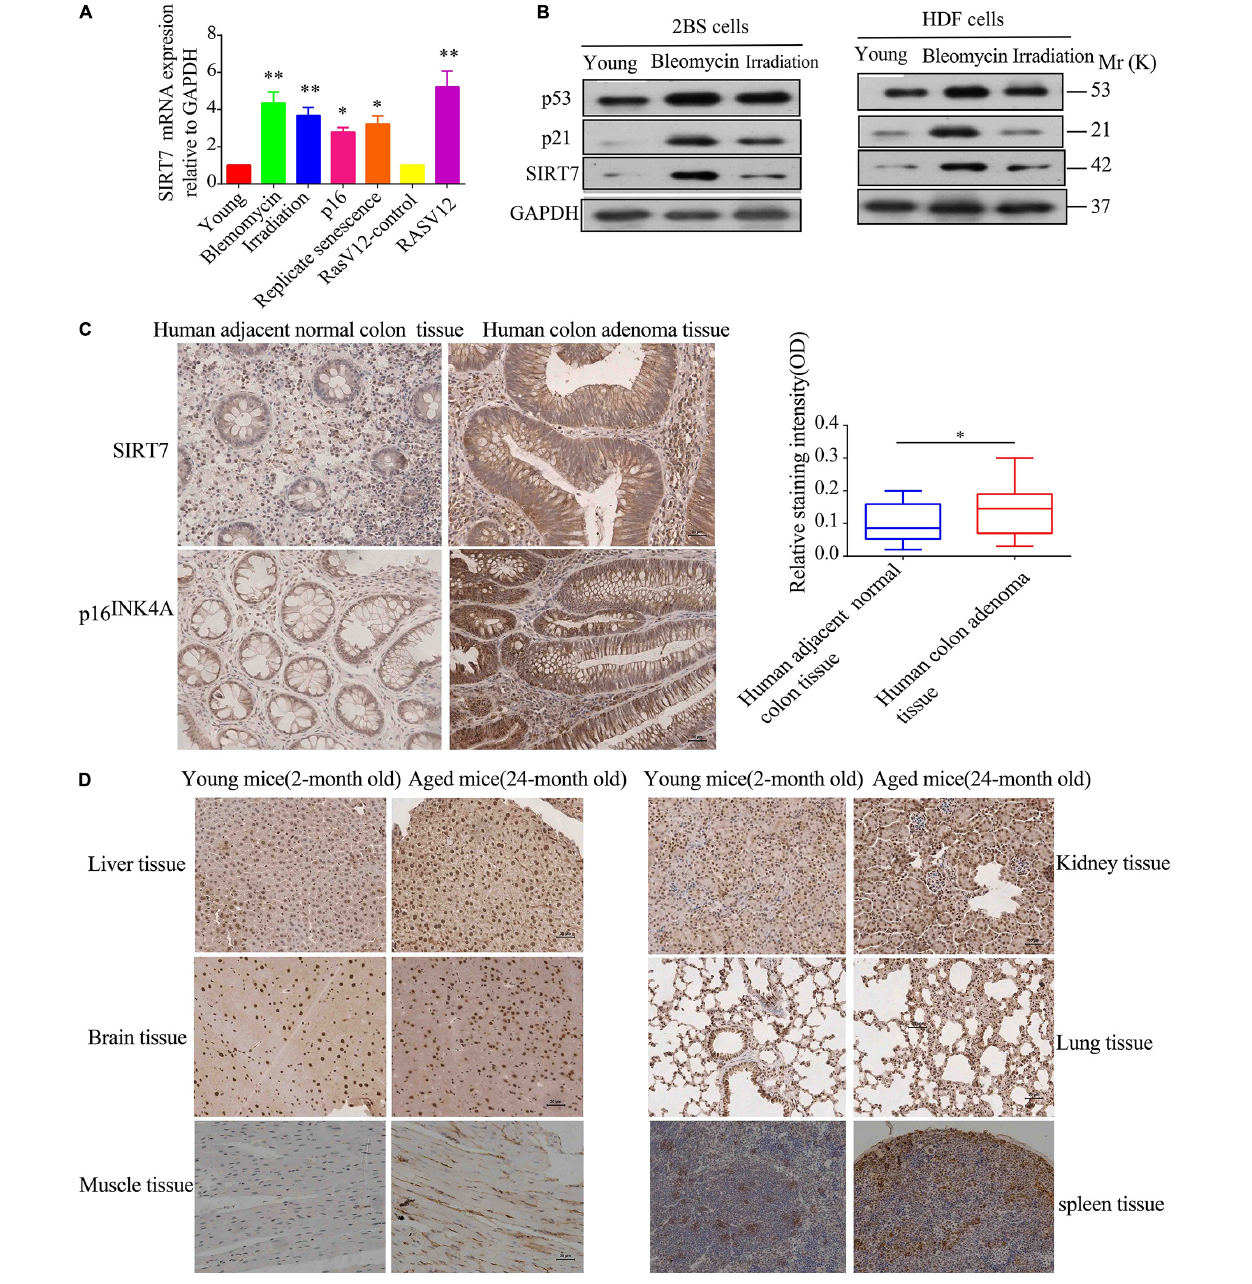
FIGURE 1 | SIRT7 expression in senescent fibroblasts and aged tissues. (A) The mRNA expression level of SIRT7 in various senescent cells, young cells, or control cells; the experiments were repeated three times, ∗ P < 0.05, ∗∗ P < 0.01. (B) The protein expression level of SIRT7 in various senescent cells and young cells; the experiments were repeated three times. (C) SIRT7 expression in human colon adenoma and human adjacent normal colon tissue, n = 10, statistical analysis by t -test, ∗ p < 0.05. Scale bar = 30 µ m. (D) Expression of SIRT7 in various tissues of naturally aged mice and young mice, n = 3. Scale bar = 30 µ